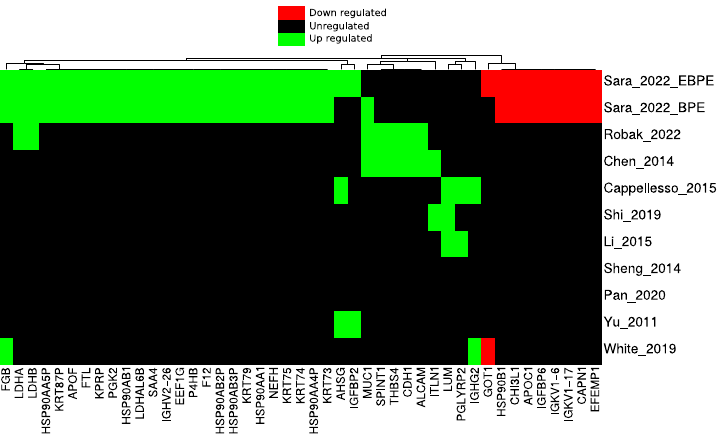
Figure 7. Heatmap of dysregulated proteins, separated into up, down and unregulated groups, comparing this study with previous PE studies.